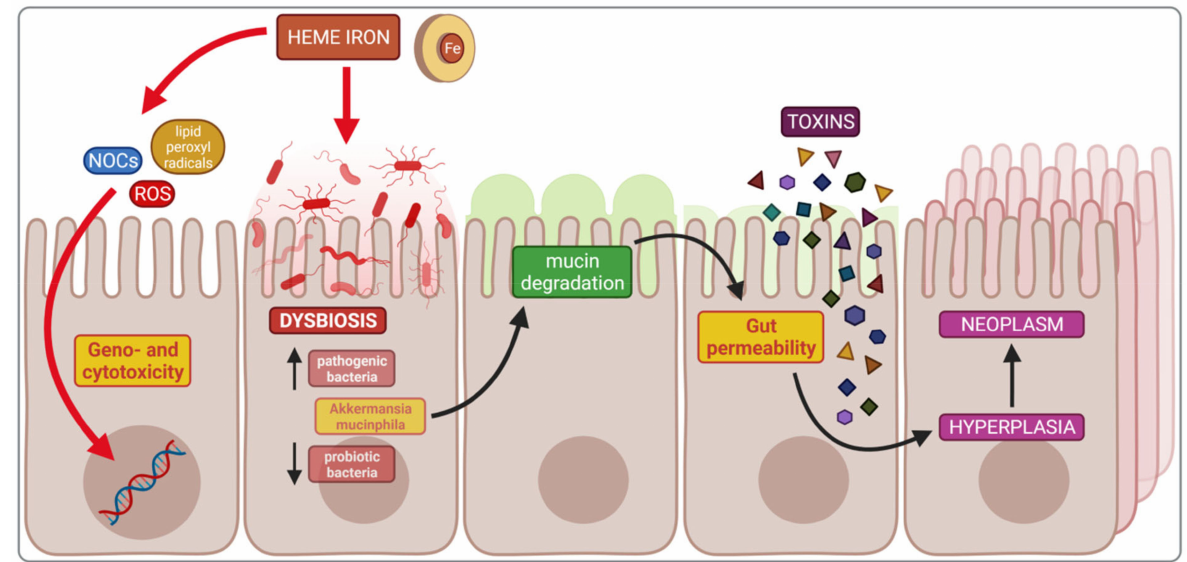
Figure 4. Mechanisms of heme iron induction of colorectal carcinogenesis. NOCs— N -nitroso com- pounds; ROS—reactive oxygen